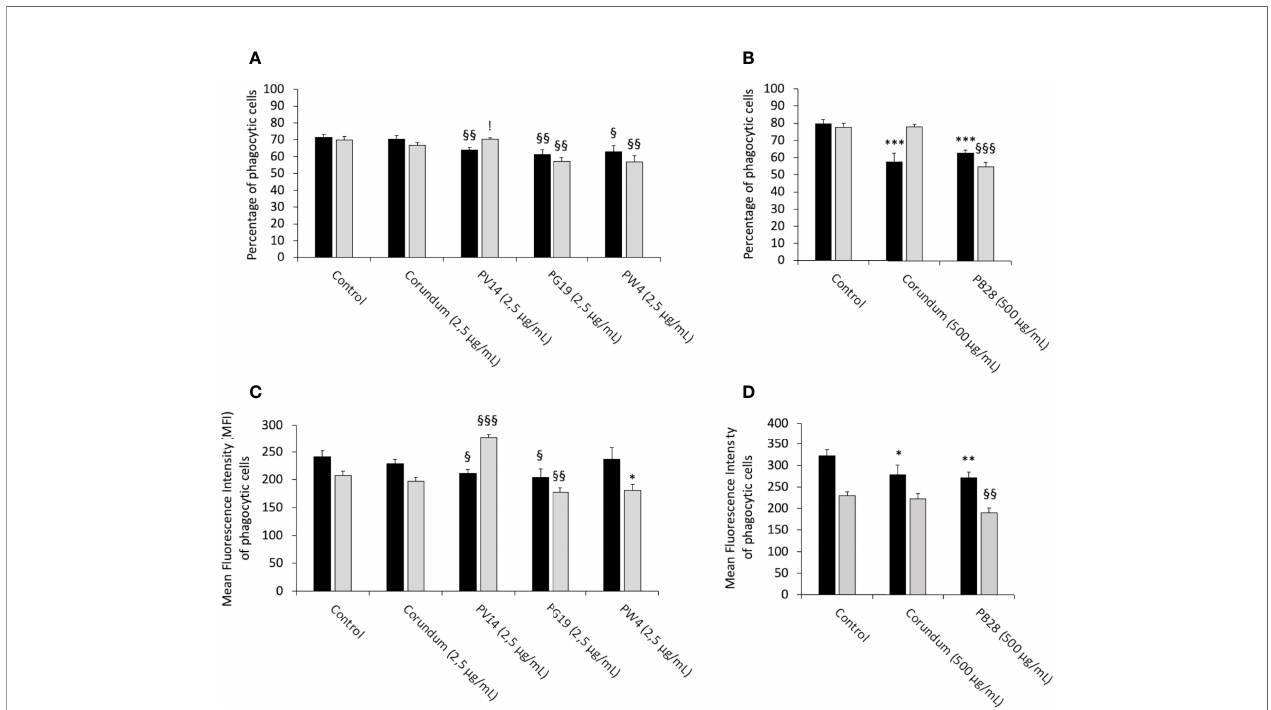
FIGURE 7 | Phagocytic capacity. Black bars: acute exposure (24 hours). Grey bars: Exposure for 24 hours followed by a 3-day post-exposure recovery period. Panel (A) conditions with 2.5 µg/ml of particle suspension. Percentage of cells able to phagocytose fl uorescent FITC-labeled latex beads (positive cells). Panel (B) conditions with 500 µg/ml of particle suspension. Percentage of cells able to phagocytose fl uorescent FITC-labeled latex beads (positive cells). Panel (C) measurement of the phagocytic ability (mean fl uorescent intensity) of positive cells. Conditions with 2.5 µg/ml of particle suspension. Panel (D) measurement of the phagocytic ability (mean fl uorescent intensity) of positive cells. Conditions with 500 µg/ml of particle suspension. Signi fi cance of symbols: *: different from negative control only; § different from both negative and corundum controls;!: different from corundum control only. Number of symbols: 1: p < 0.05; 2: p < 0.01; 3: p <